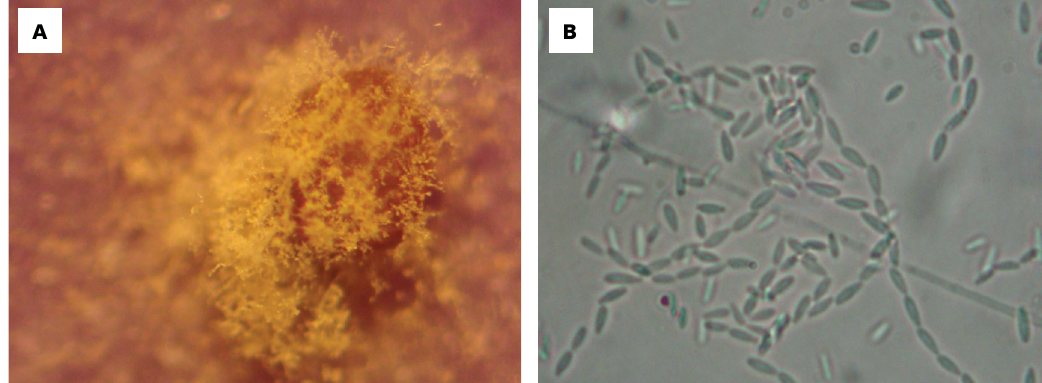
Figure 2. (A) Growth of Fusarium verticillioides in tobacco seed; (B) conidia of F. verticillioides .